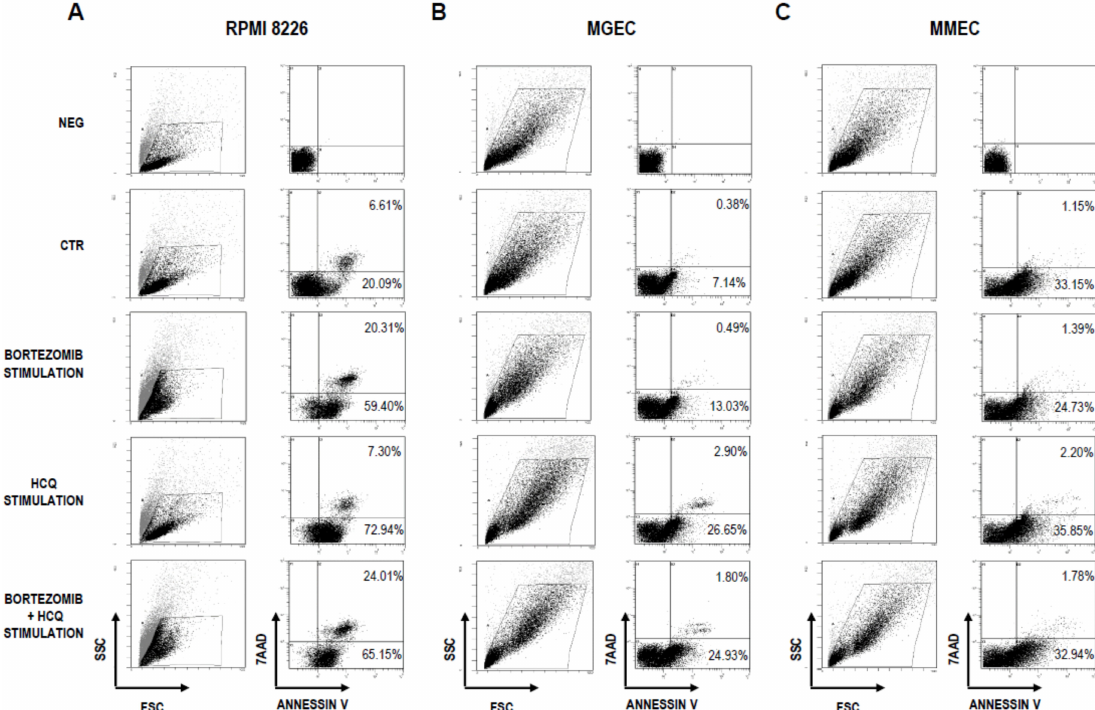
Figure 7. E ff ect of combination treatment with bortezomib and HCQ on cell cytotoxicity. Representative flow cytometry plots show changes in cytotoxicity for ( A ) RPMI 8226 cells, ( B ) MGECs ( n = 9), and ( C ) MMECs ( n = 11) treated with or without bortezomib (10 nM), HCQ (100 uM), or with both drugs for 24